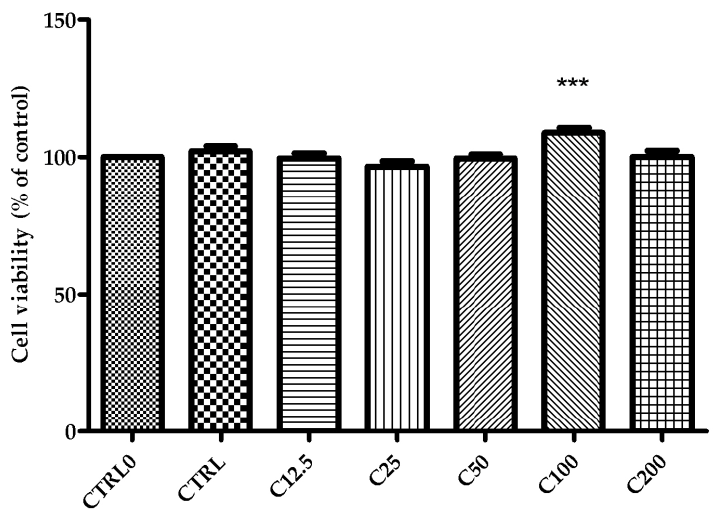
Figure 3. Effect of SM extract concentrations (between 12.5 µ g/mL and 200 µ g/mL) on viability of NHDF after 24 h. CTRL0—untreated cells; CTRL—positive control (cells treated with allantoin 50 µ g/mL). Data are expressed as the mean ± SD from three individual experiments. *** p < 0.001 versus CTRL0.